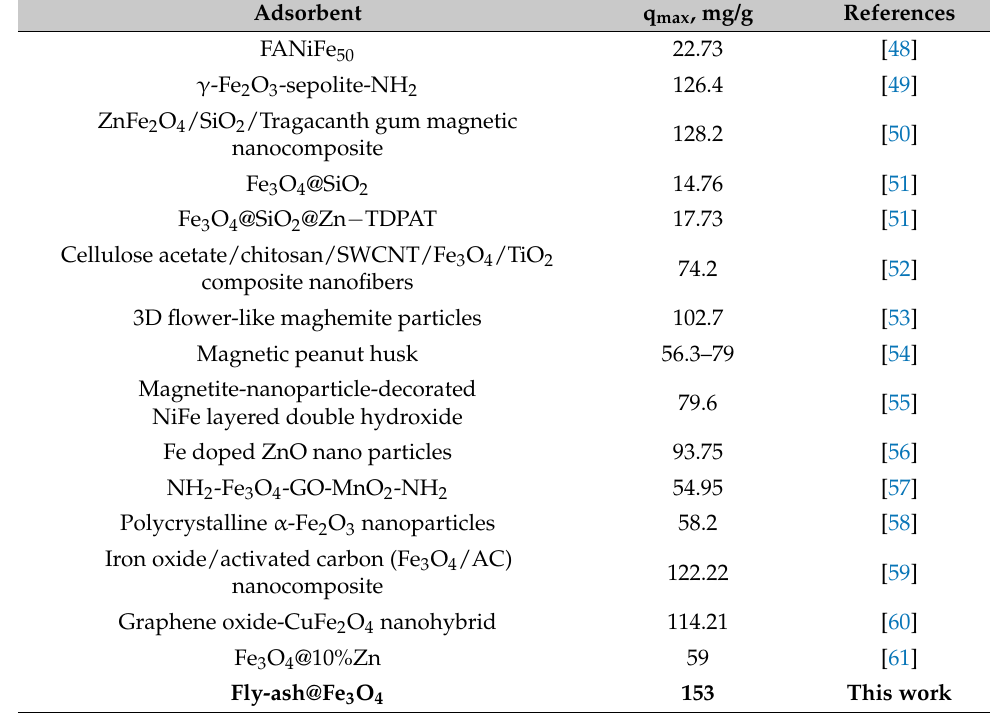
Table 5. Comparison of maximum adsorption capacities of different magnetic adsorbents for Congo red.